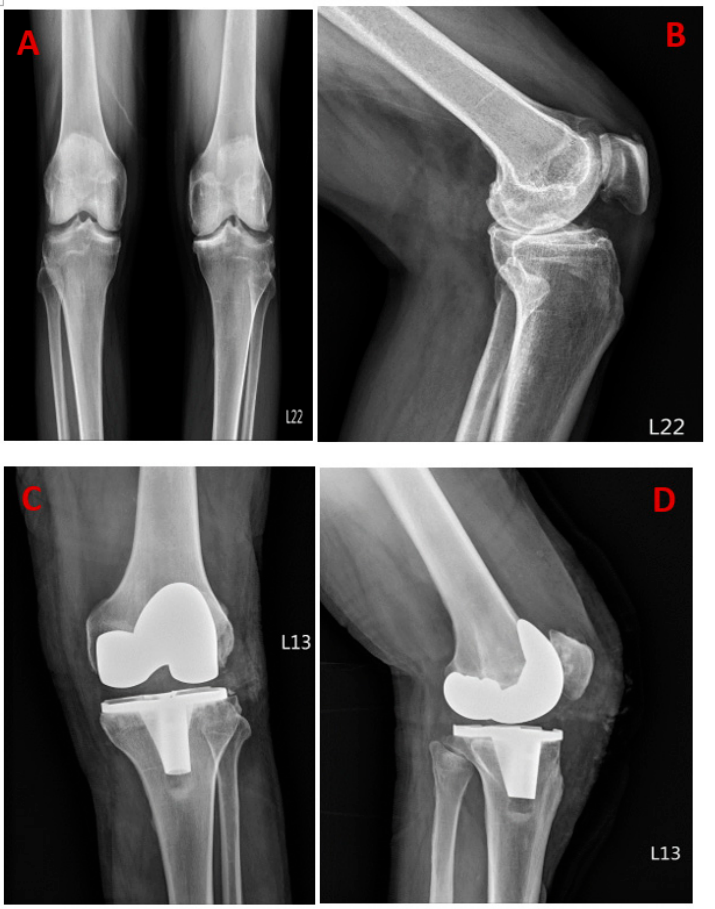
Figure 1. Initial radiography images before total knee replacement ( A , B ) with successful post-surgery radiography ( C , D ).